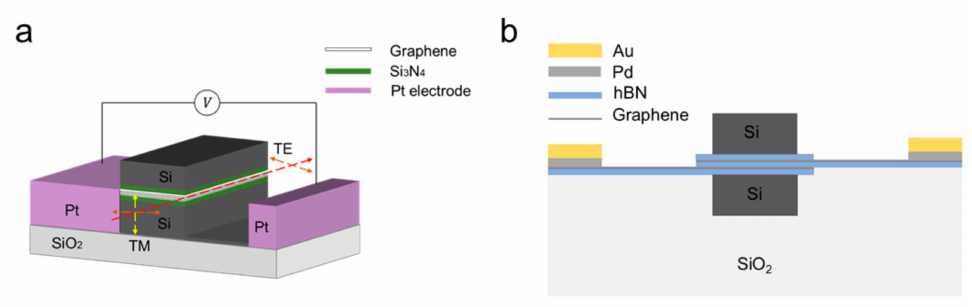
Figure 8. ( a ) Schematic of the polarization modulator. ( b ) Schematic of graphene-based optical phase